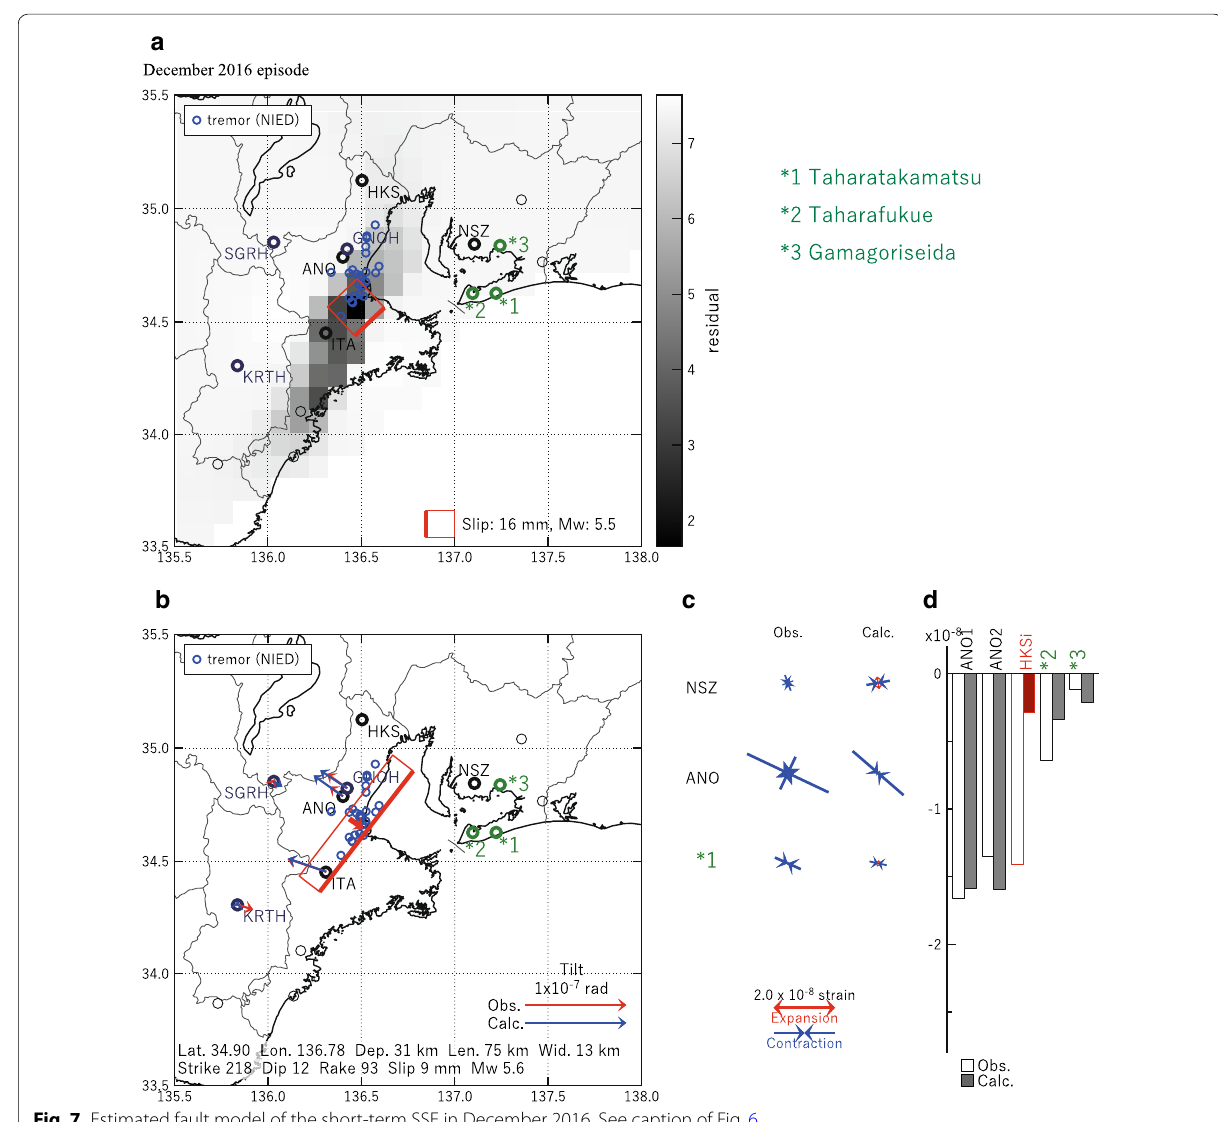
Fig. 7 Estimated fault model of the short-term SSE in December 2016. See caption of Fig.